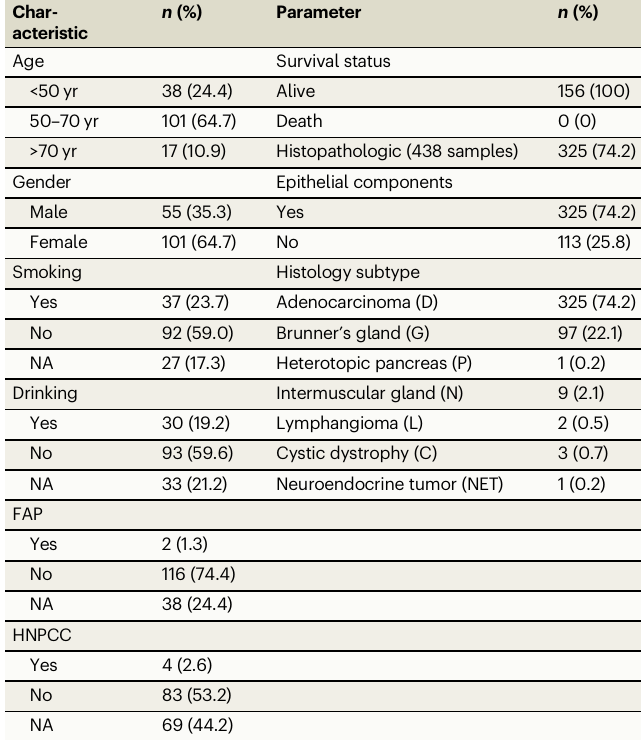
Table 1 | Clinical and histopathologic characteristics of the Fudan DC cohort ( n = 156) Char-